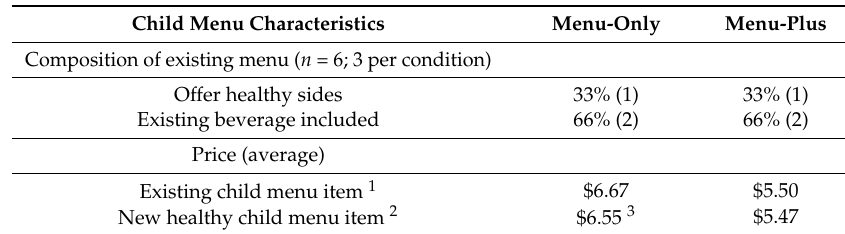
Table 2. Characteristics of existing child menu items ( n = 6) and price of new healthy child menu items ( N =